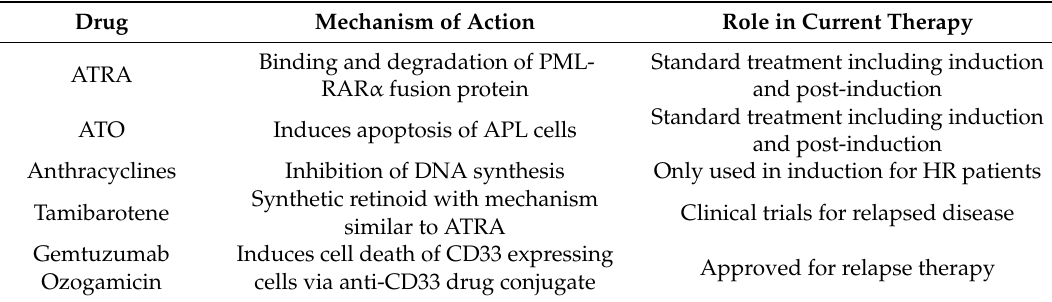
Table 1. Summary of the drugs used in acute promyelocytic leukemia (APL) therapy. Drug Mechanism of Action Role in Current Therapy Binding and degradation of PML- Standard treatment including induction ATRA RAR α fusion protein and post-induction Standard treatment including induction ATO Induces apoptosis of APL cells and post-induction Anthracyclines Inhibition of DNA synthesis Only used in induction for HR patients Synthetic retinoid with mechanism Clinical trials for relapsed Tamibarotene similar to ATRA